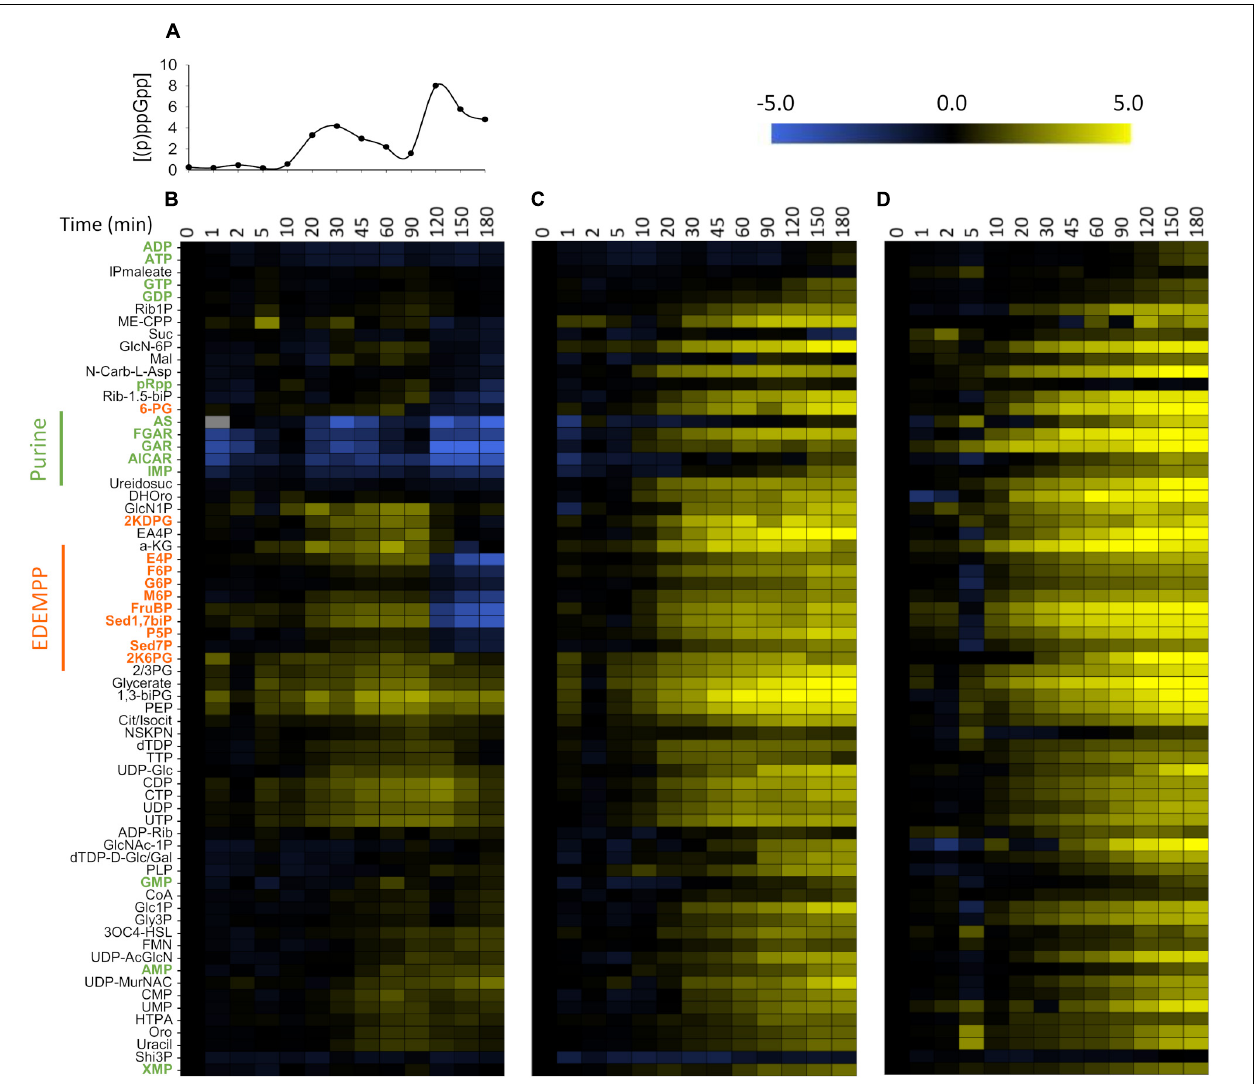
FIGURE 4 | Global metabolic response to SHX addition. Intracellular concentration profile of (p)ppGpp in WT P. putida KT2440 (A) and variations in metabolite levels in response to SHX addition in (B) wild-type (WT) P. putida KT2440, (C) the (cid:49) relA mutant and (D) the ppGpp 0 strain. The columns correspond to different time points just before ( t = 0 min) and after SHX addition. Metabolome dynamics were determined from LC-MS 12 C/ 13 C quantitative data on 67 metabolites. Fold-changes (log 2 ) were calculated relative to exponentially growing cells. Metabolites in the WT strain were hierarchically clustered based on Pearson correlation coefficients. For simplicity, the metabolites are displayed in the same order for the (cid:49) relA and ppGpp 0 strains as for the WT. The data shown were extracted from the same biological replicate as shown in Figures 1 , 2 . The corresponding results for the two other biological replicates are shown in Supplementary Figure 6 and the log 2 ratios of the relative metabolite concentration changes for the three biological replicates are given in supplementary material. Non-canonical abbreviations are given in the legend of Supplementary Figure 6